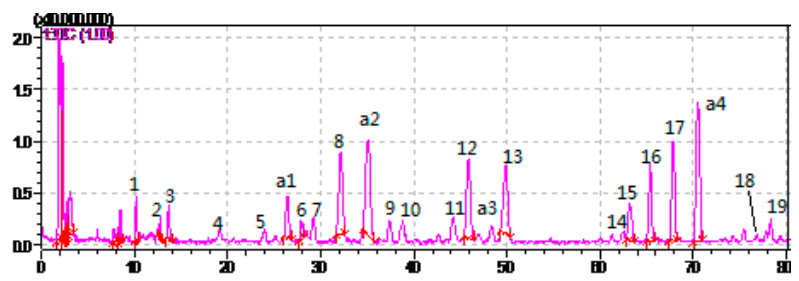
Figure 2. HPLC chromatograms of P. cocos .